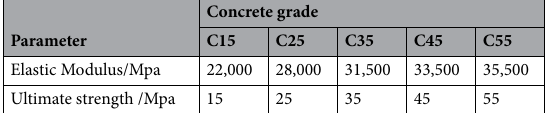
Table 2. Parameters of different concrete grades.